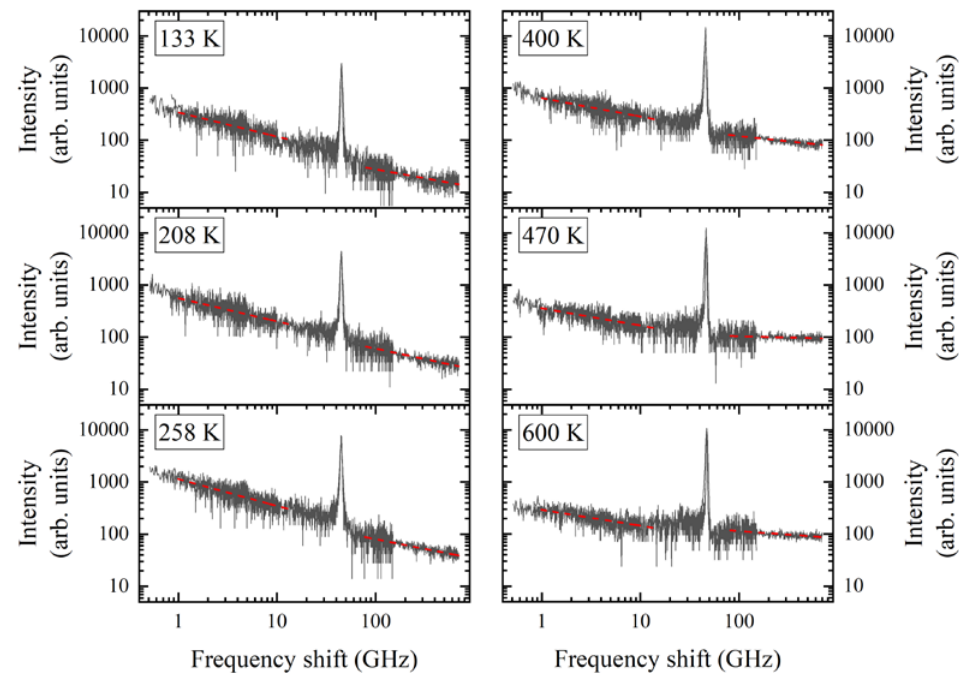
Figure 1. Combined spectra of Brillouin scattering in a PMN crystal obtained by “merging” the experimental spectra with different free spectral intervals (see text). Red dashed line is the result of a linear approximation.